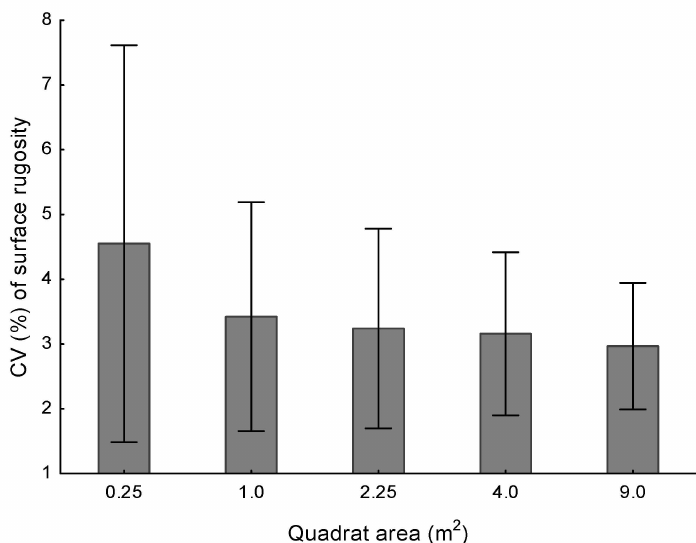
Figure 8. Average ( ˘ S.D.) precision (CV) in surface rugosity (SR) estimates amongst models derived from replicate photogrammetric modelling of a 120 m 2 area of benthic habitat. A grid of non-overlapping virtual square quadrats of a specific area was laid over the model domain and the variation in the mean SR value from each of the three models in a quadrat was calculated. This process was done for five different quadrat areas. Sample sizes were 456, 114, 48, 27, and 12 for 0.25, 1, 2.25, 4, and 9 m 2 quadrats, respectively.